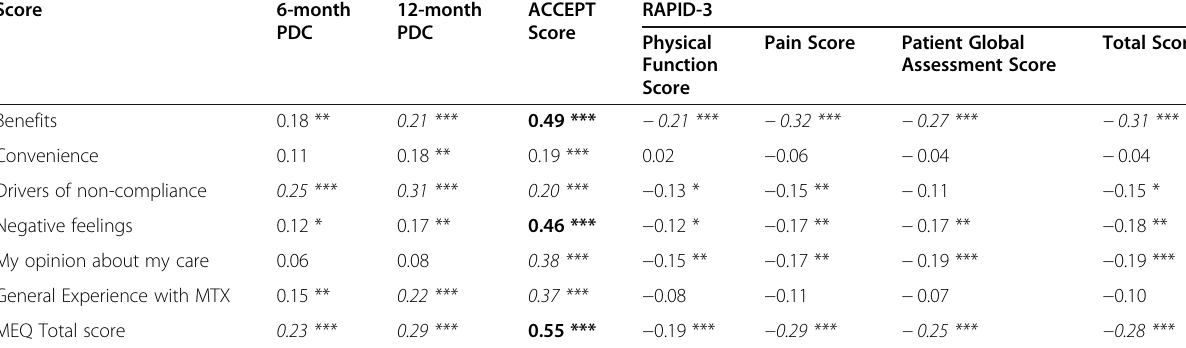
Table. 3 Pearson correlation coefficients of MEQ scores with PDC and other concurrent scales scores